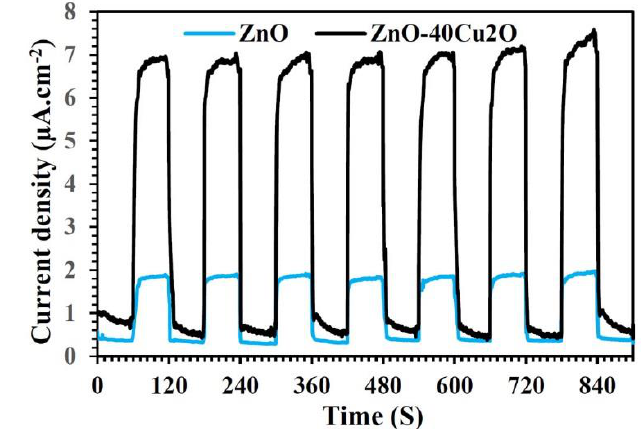
Fig. 4. PL spectra of the prepared